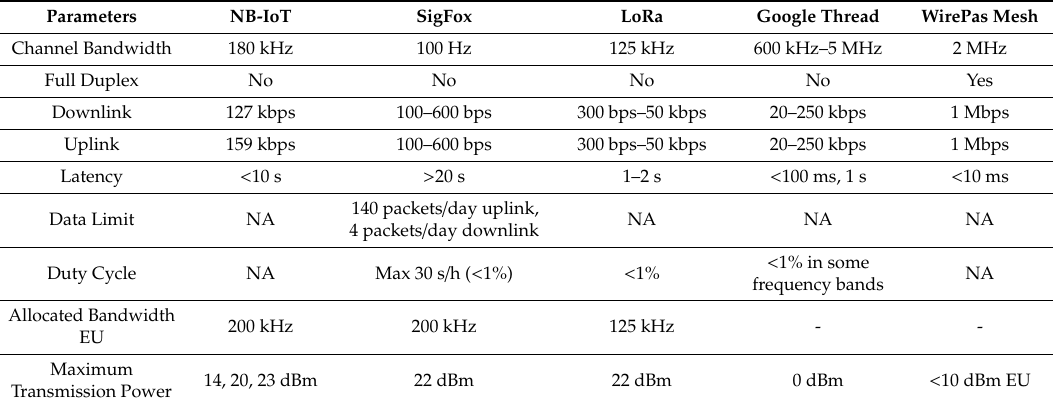
Table 1. Comparison of IoT communication